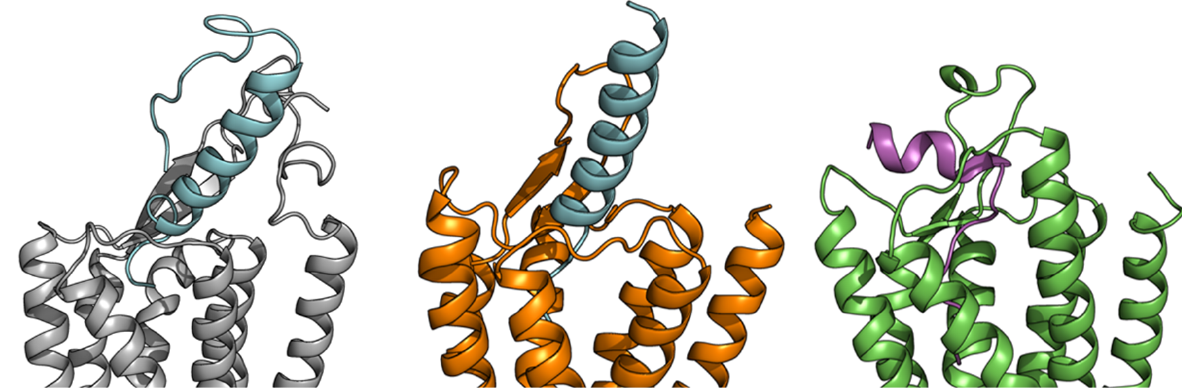
Figure 8. Models of peptide/class A GPCR complexes show that the peptides interact with the top 14 common residues. (From left to right ): A table lists the ΔΔ Gs values of the 14 common residues of Y1 [56], Y2 [14], and ghrelin receptors [72], as well as their sum and average values. The absence of the ΔΔ G values indicates that the corresponding residues do not interact with the peptide ligands. The residue ΔΔ G cells are colored based on the ΔΔ G values (negative: Blue, neutral: White, and positive: Red). The blank cells indicate that the residues do not interact with the peptide ligands. Models of NPY (cyan) bind with the Y1 receptor (grey) and the Y2 receptor (orange), and ghrelin (magenta) binds with the ghrelin receptor (green).